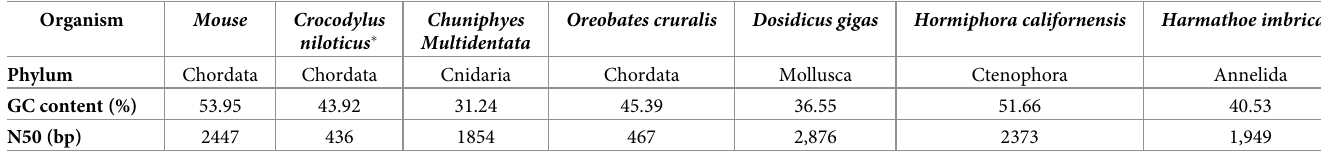
Table 2. Comparison of GC content and N50 of assembled transcriptomes of selected non-model organisms.